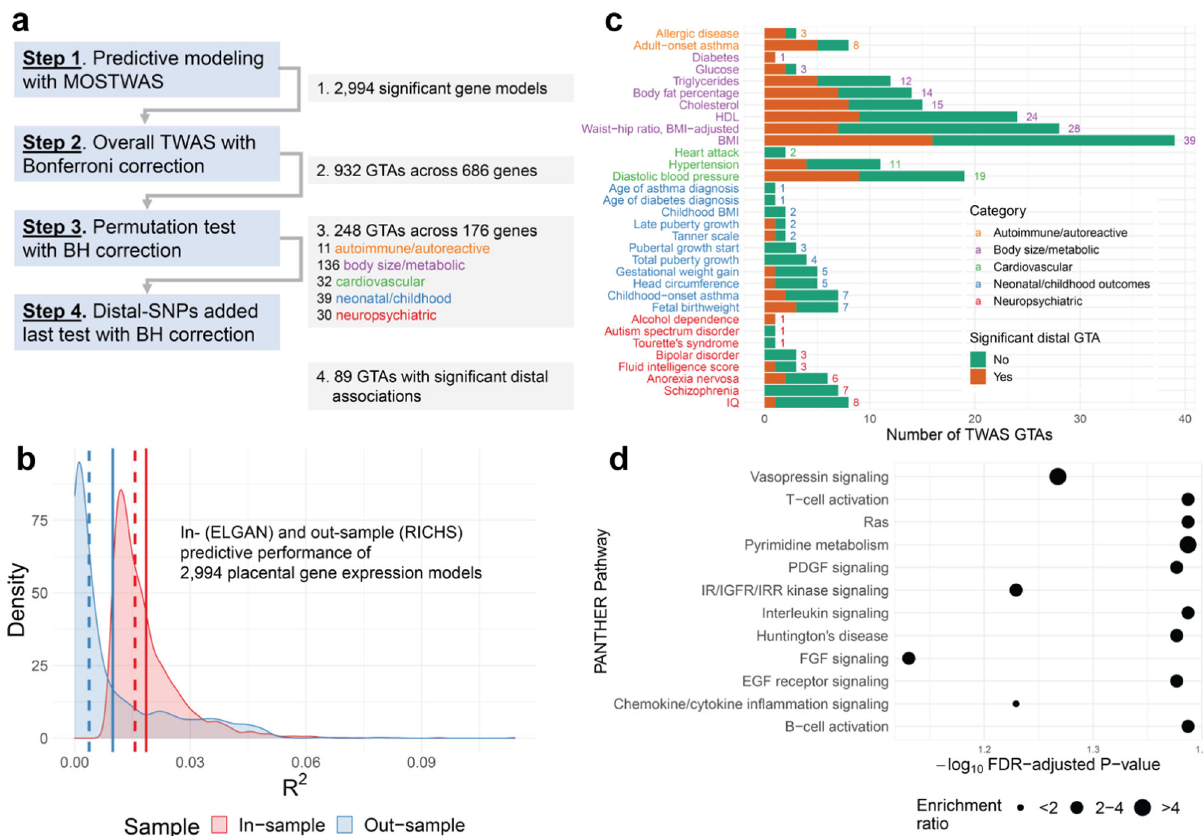
Fig. 3 Placental MOSTWAS prediction and association test results. a Overview of TWAS association testing pipeline with number of gene-trait associations (GTAs) across unique genes over various levels of TWAS tests. b Kernel density plots of in- (through cross-validation in ELGAN, red) and out- sample (external validation in RICHS, blue) McNemar ’ s adjusted R 2 between predicted and observed expression. Dotted and solid lines represent the mean and median of the respective distribution, respectively. c Bar graph of numbers of TWAS GTAs at overall TWAS P < 2 : 5 ´ 10 (cid:1) 6 (for two-sided weighted burden Z -test) and two-sided permutation test FDR-adjusted P < 0 : 05 ( x -axis) across traits ( y -axis). The total number of GTAs per trait are labeled, colored by the category of each trait. The bar is broken down by numbers of GTAs with (orange) and without (green) signi fi cant distal expression-mediated associations, as indicated by FDR-adjusted P < 0 : 05 for the distal-SNPs added-last test. d Enrichment plot of over-representation in 176 TWAS genes of PANTHER pathways ( y -axis) with -log 10 FDR-adjusted P -value ( x -axis) of one-sided Fisher ’ s exact test. The size of the point gives the relative enrichment ratio for the given